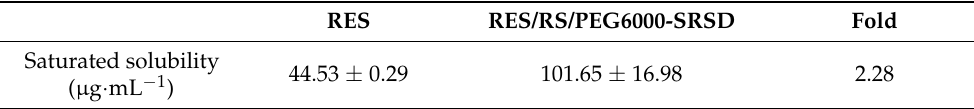
Table 4. Saturated solubility of RES and RES/RSPEG6000-SRSD.